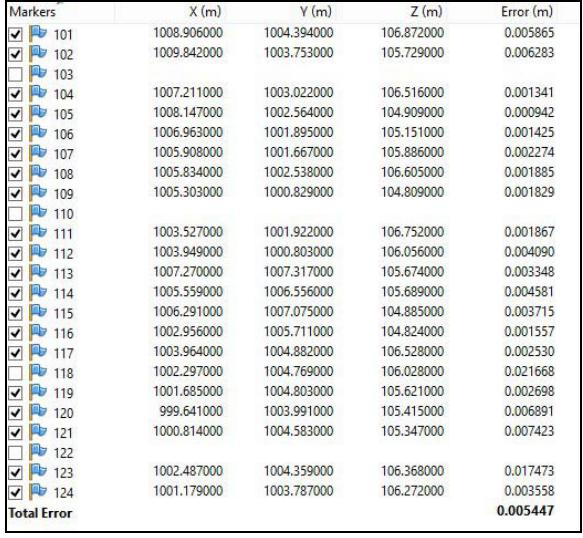
Figure 19 – Assessment chart of the accuracy in photogrammetric software and view of GRP’s / GCP’s on the